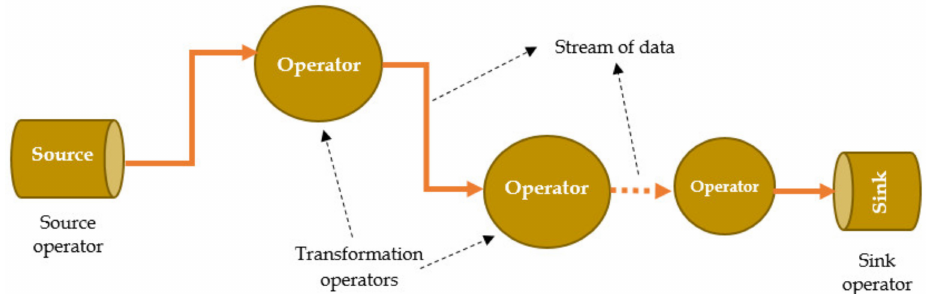
Figure 10. A data flow graph in Flink. Here, edges represent data streams and each vertices represent